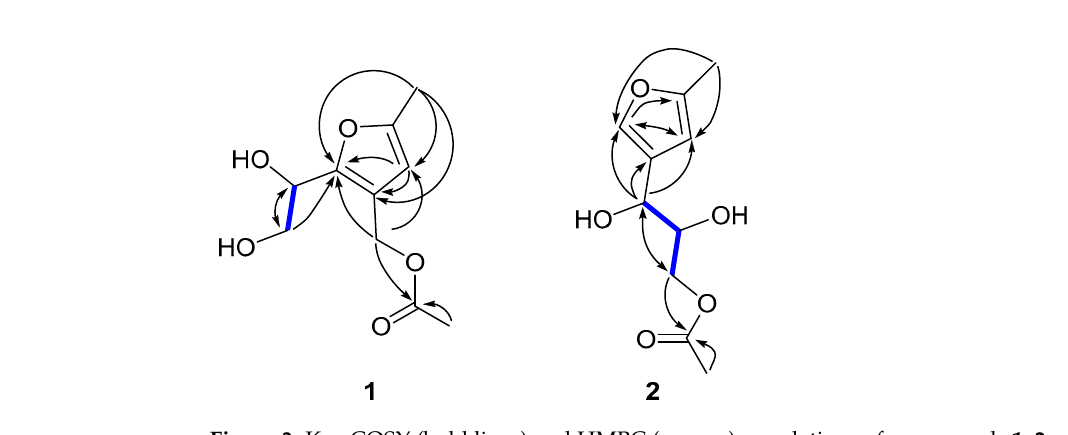
20.7, CH 3 The planar structure of 1 was deduced by combined interpretation of 1 H- 1 H COSY, HSQC, and HMBC correlations (Figure 3, Figure S7, Figure S8 and Figure S9). A 2,4,5- trisubstitued furan ring was established by the HMBC correlations of H-3 to C-2, C-5, and C-4, respectively. The HMBC correlations of H-1 to C-2, C-3, C-5, and C-4 suggested that